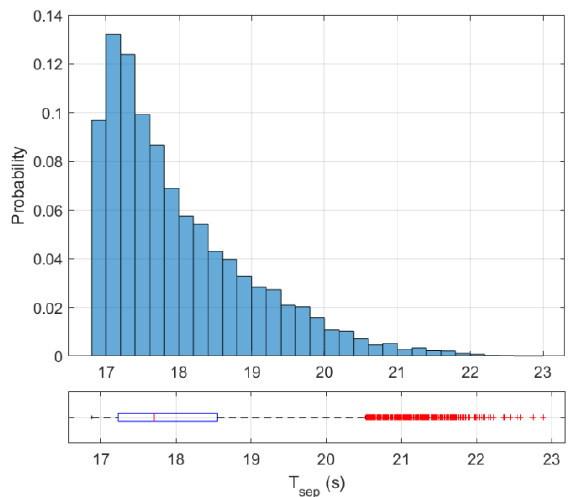
Figure 5. A normalized histogram of the separation period. Below the histogram is the box plot where the blue box represents the interquartile range (IQR). The vertical red line in the box corresponds to the median. Meanwhile, the red crosses on the right-hand side represents outliers (1.5 × IQR above the third quartile).